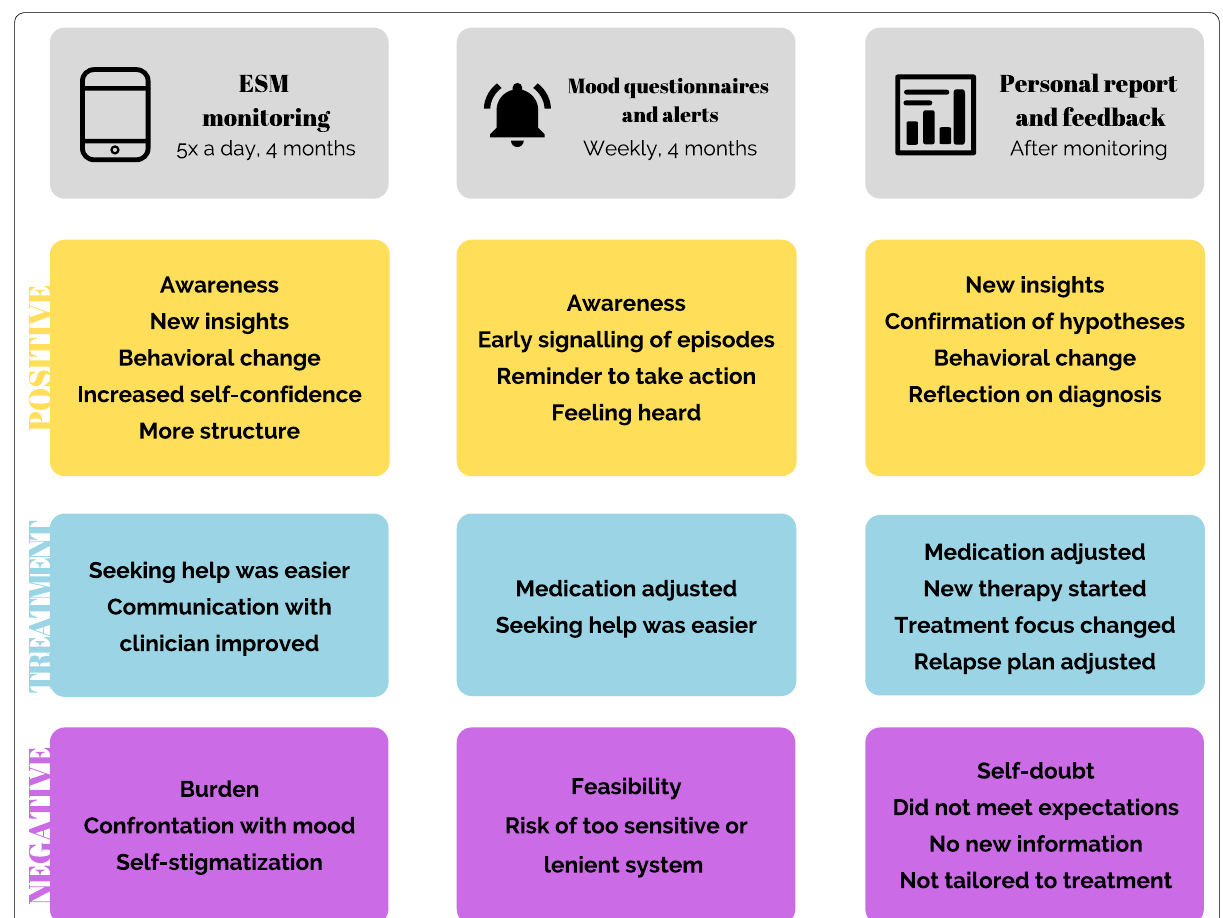
Fig. 2 Schematic overview of the main findings of the first three themes: perceived effects of ESM monitoring, the weekly questionnaires (ASRM/ QIDS) and alerts, and the personal report and feedback